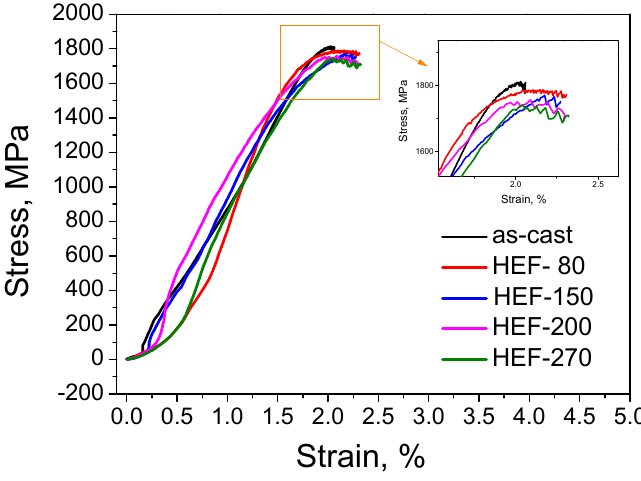
Figure 11. Fracture stress–strain curve of the as ‐ cast and HEF ‐ treated samples.